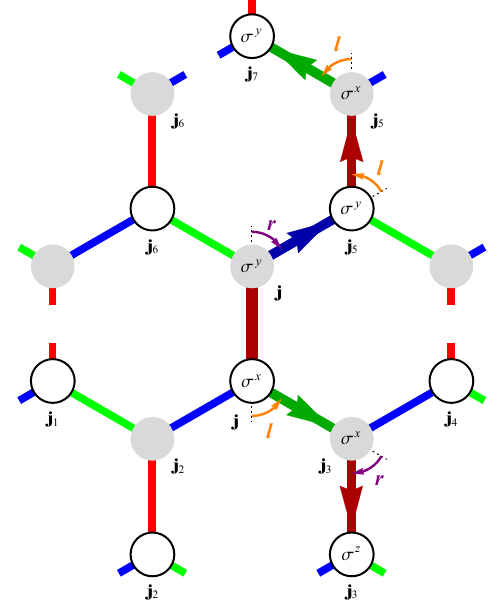
= σ y σ x σ y σ y σ x σ x σ z on the Bethe lattice. Ver- j 5 B j A j 3 B j 3 A j 7 A j 5 A j B lr j